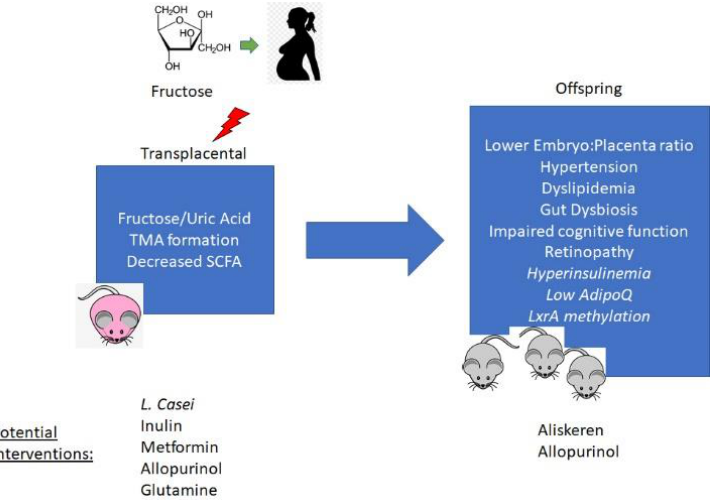
Figure 1. Mechanisms of developmental programming of offspring phenotypes by maternal fruc- exposure and potential options for preventive interventions. TMA—trimethylamine; SCFA—short tose exposure and potential options for preventive interventions. TMA — trimethylamine; SCFA — chain fatty acids; LxrA—Liver-X-receptor short chain fatty acids; LxrA — Liver-X-receptor alpha.